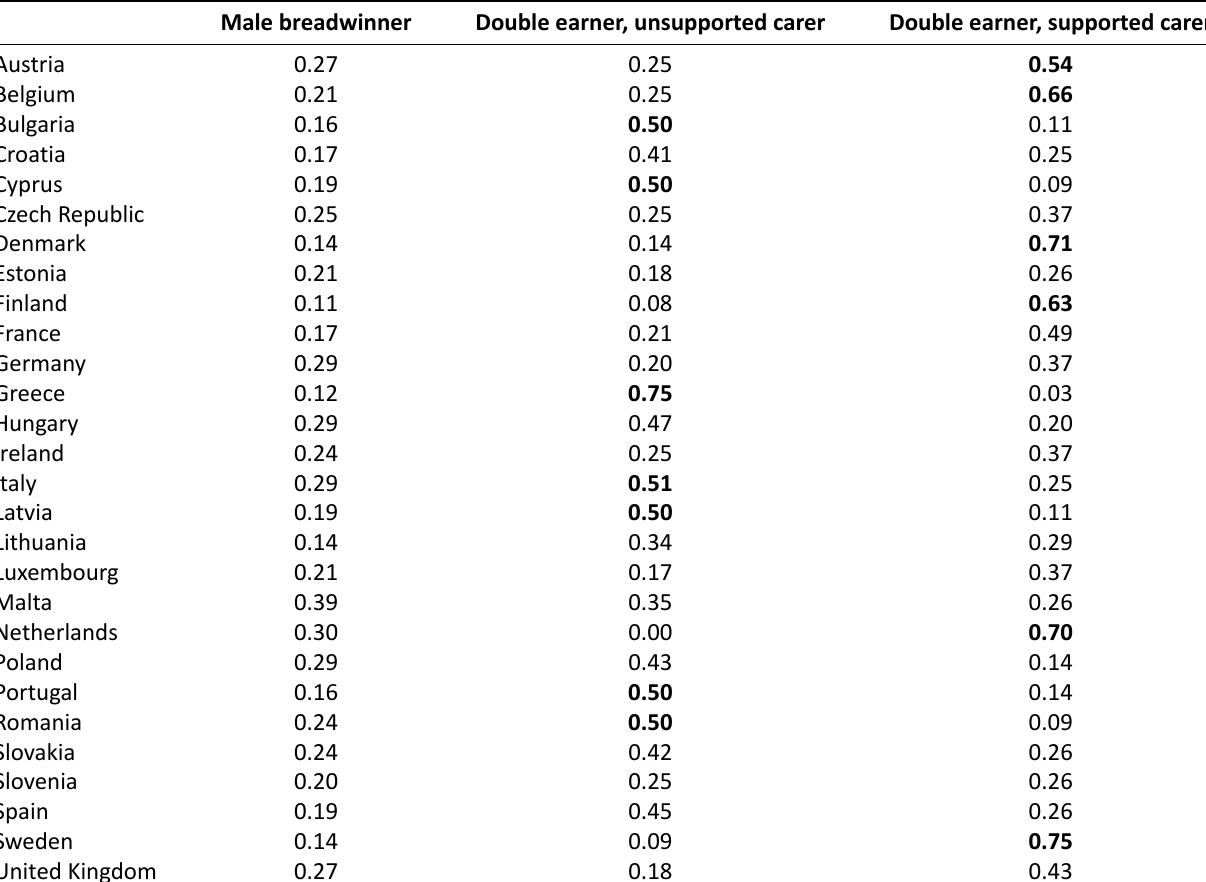
Table 4. Fuzzy-set membership scores by ideal types. Male breadwinner Double earner, unsupported carer Double earner, supported carer